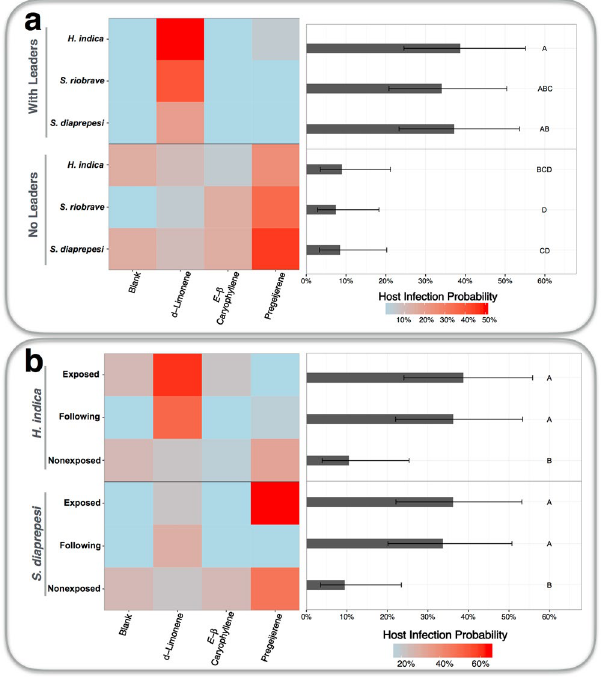
Figure 5. Social Behavioral Plasticity in Parasitoids affects Host Infection. ( a ) Cohorts of entomopathogenic infective juveniles exposed to d-limonene can influence infective juveniles of other species resulting in increased host infection probability. For trials with leaders, cohorts of 50 H . indica infective juveniles exposed to d-limonene (the ‘leaders’) were paired with 2450 nonexposed infective juveniles of either H . indica , S . riobrave , or S . diaprepesi . For trials without leaders, cohorts consisted of 2500 nonexposed infective juveniles. ( b ) Mixed leader-follower cohorts mimic performance of exposed only cohorts. Exposed cohorts consisted of 2500 infective juveniles exposed to d-limonene. Following cohorts consisted of mixed groups of 50 H . indica infective juveniles paired with 2450 nonexposed infective juveniles. Nonexposed cohorts consisted of 2500 infective juveniles exposed to blank controls not consisting of plant volatiles. Bars and error bars denote mean infection probability of D . abbreviatus larvae paired with d-limonene and 95% confidence intervals respectively. Groups not sharing letters are significantly different ( P < 0.05, Tukey’s